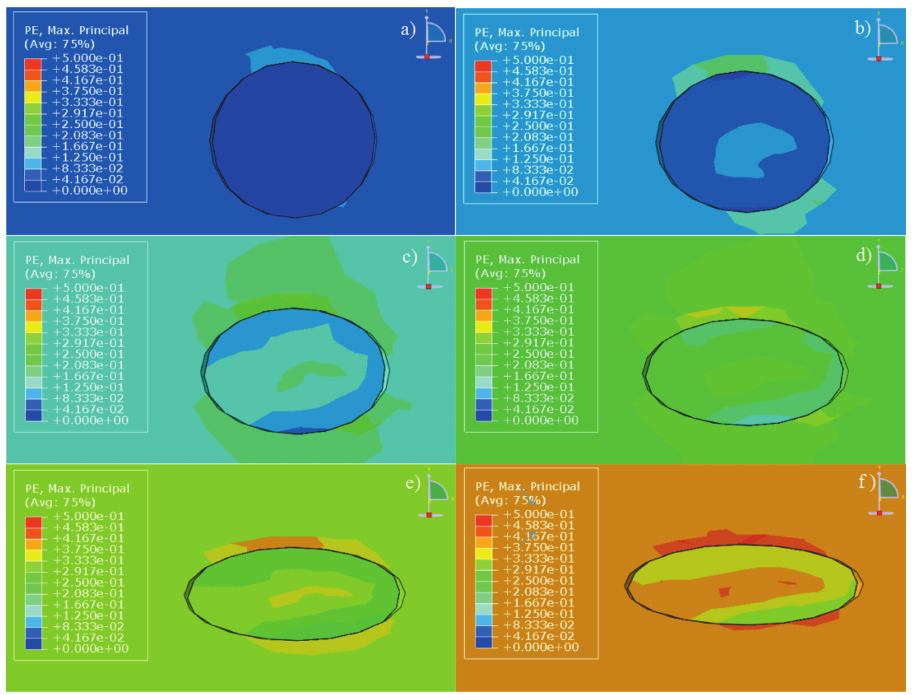
Figure 3: Plastic strain distributions of the hard inclusion at 800 ℃ with the following reductions: a) 10mm; b) 20mm; c) 30mm; d) 40mm; e) 50mm; f) 60mm.